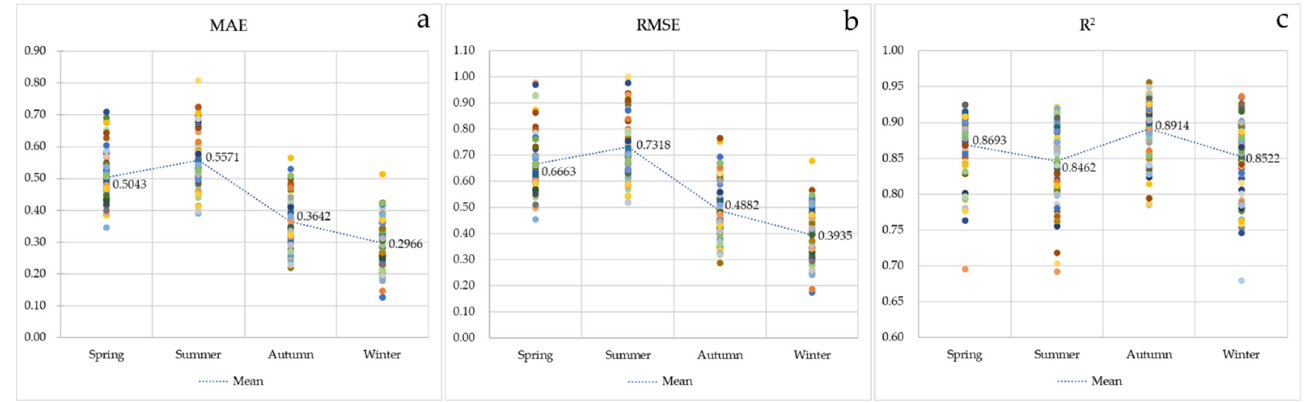
Figure 10. Numerical range distribution of MAE ( a ), RMSE ( b ) and R 2 ( c ) using the Sen Model for the 72 stations.